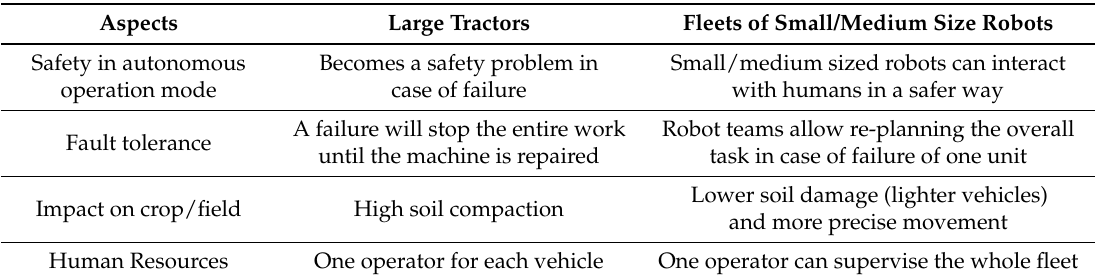
Table 1. Use of fleets of small-sized robots versus use of large platforms.